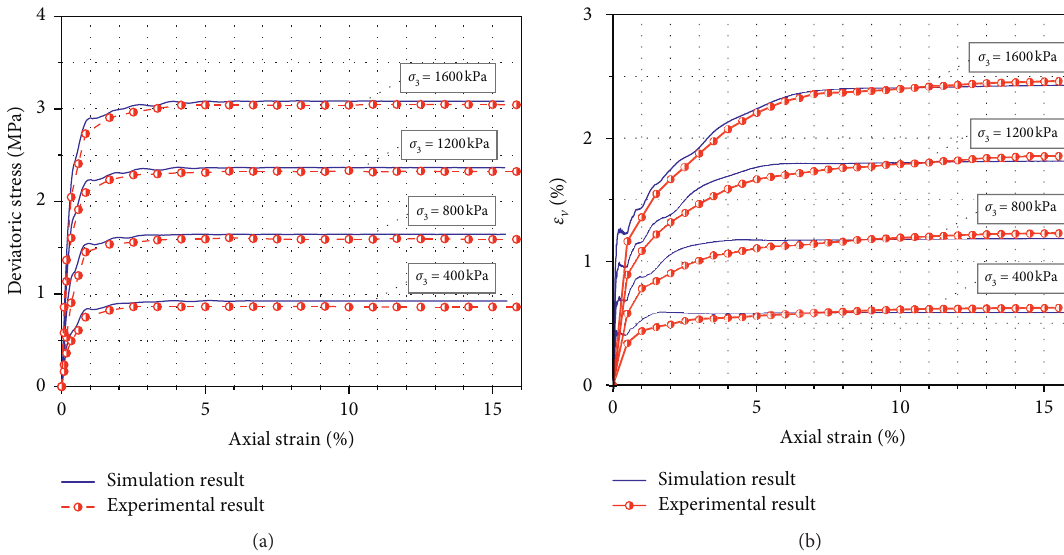
Figure 9: Comparison of laboratory test results and simulation results: (a) stress-strain curve; (b) volumetric strain curve.